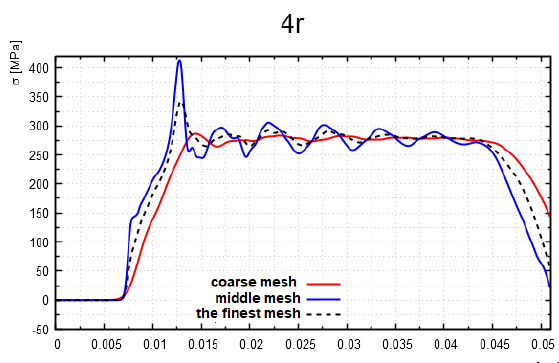
Figure 7. Comparison of the finest, the middle and the coarse mesh